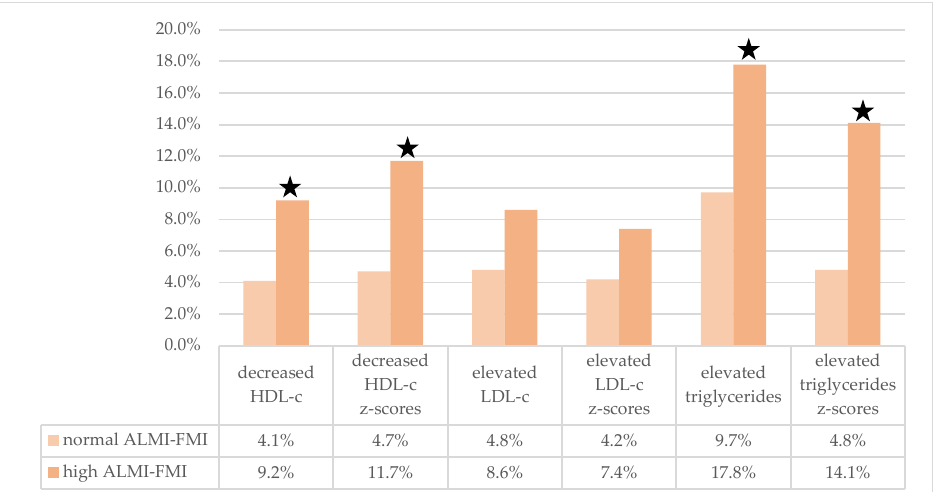
Figure 3. Prevalence of altered lipid profiles in the high ALMI – FMI and the normal ALMI – FMI groups. Figure shows the prevalence of elevated (for HDL-c decreased, respectively) serum lipid levels in the high. ALMI – FMI and the normal ALMI – FMI groups. Star indicates a p -value < 0.05 according to Fisher’s Exact test after applying Bonferroni– Holm multiple testing correction. Table 3. Characteristics of body composition